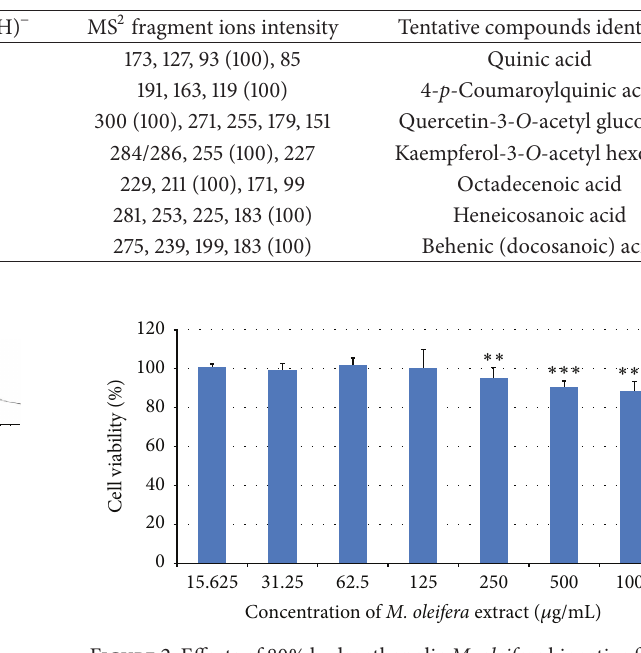
Figure 2: Effects of 80% hydroethanolic M. oleifera bioactive flower extract on the viability of RAW 264.7 macrophages. A density of 1 × 10 5 cells/well of macrophages were seeded in 96-well plate and incubated with various concentrations of flower extract for 24 h. Cell viability was determined by MTT assay. The data are presented as mean ± SD of three independent experiments. ∗∗∗ 𝑝 < 0.001 , ∗∗ 𝑝 < 0.01 versus culture media without flower extract which